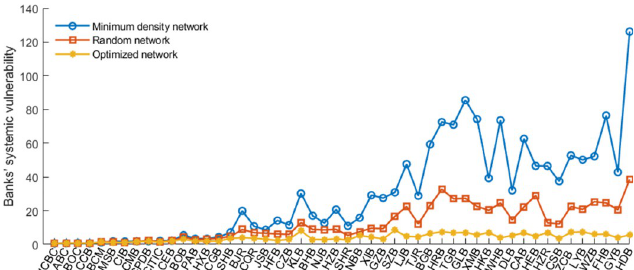
Fig 10. The banks’ average systemic vulnerability in different